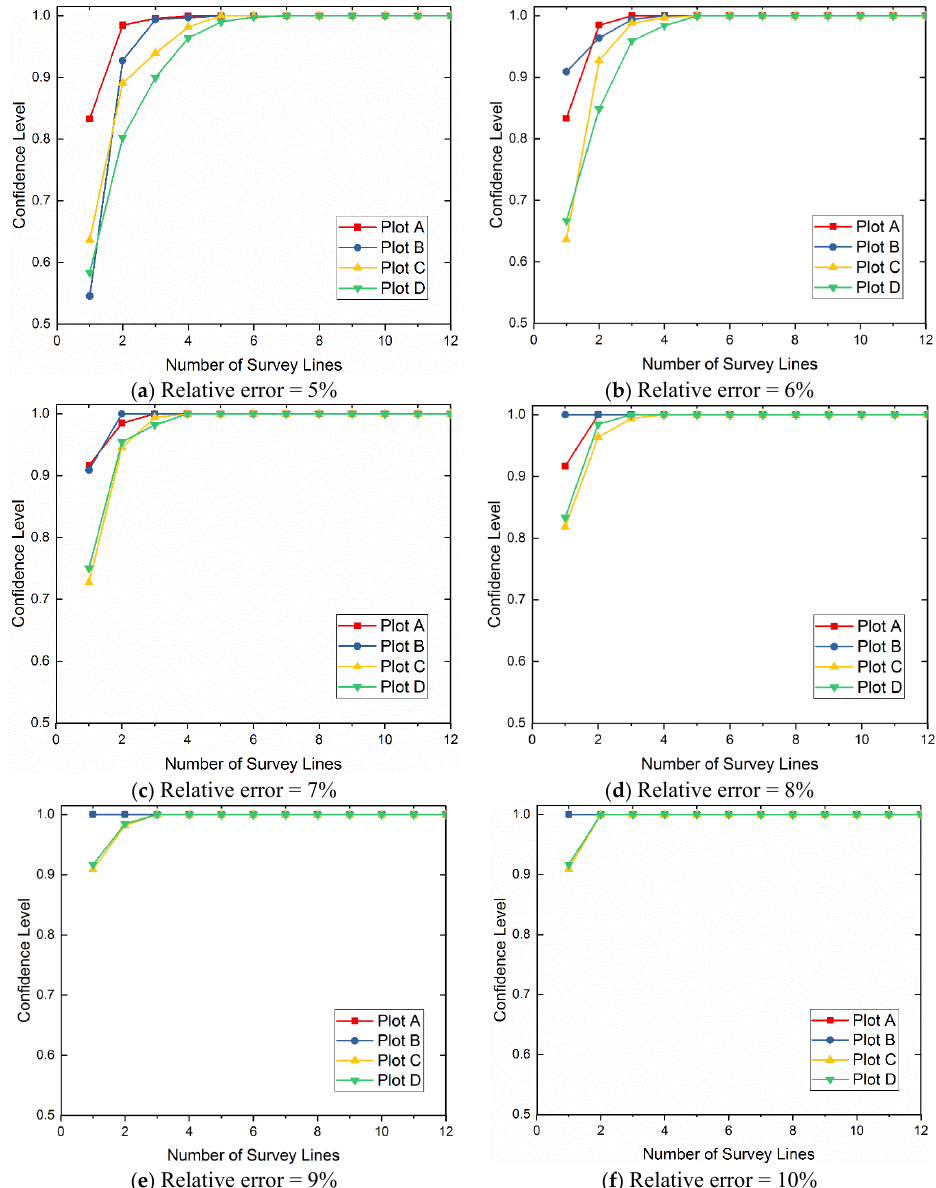
Figure 4. Relationship between the confidence level and number of survey lines under a given relative error ranging from 5% to 10% in Plot A, B, C and D.